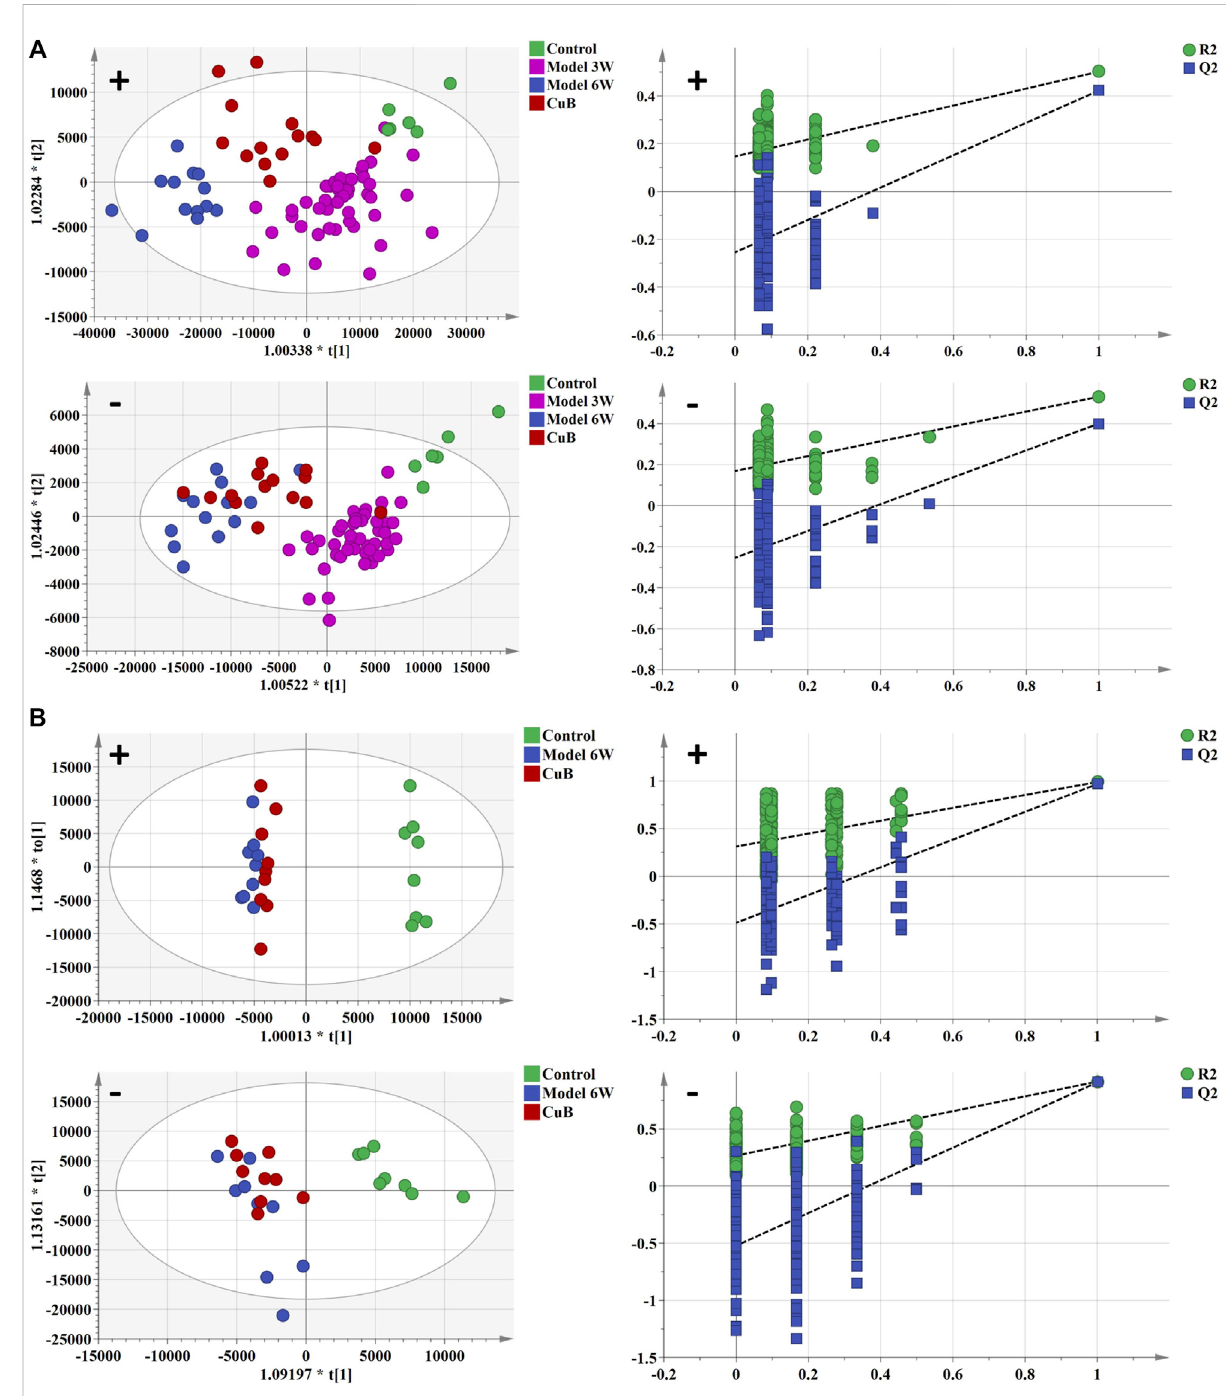
FIGURE 4 TheOPLS-DAanalysisandpermutationtestofserumandliverinpositiveandnegativeionmodeofcontrolgroup,earlystageofHCC,formative stage of HCC, and CuB group. (A) serum metabolism pro fi le and (B) liver metabolism pro fi le. Green spot represents the control group, purple spot represents the early stage of HCC, blue spot represents the formative stage of HCC and red spot represents the CuB